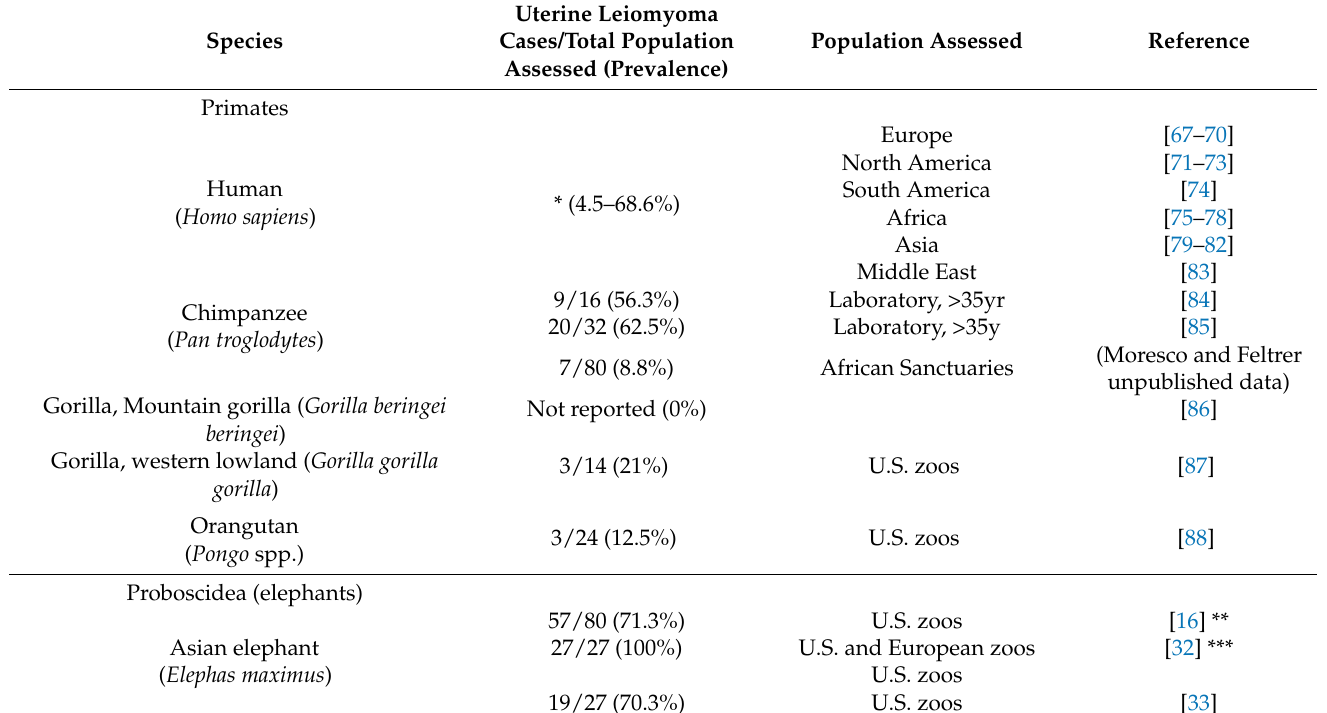
Table 2. Summary of studies evaluating prevalence of uterine leiomyomas, total populations included individuals without